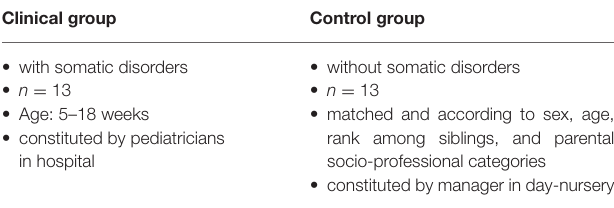
TABLE 1 | Characteristics of the control and clinical